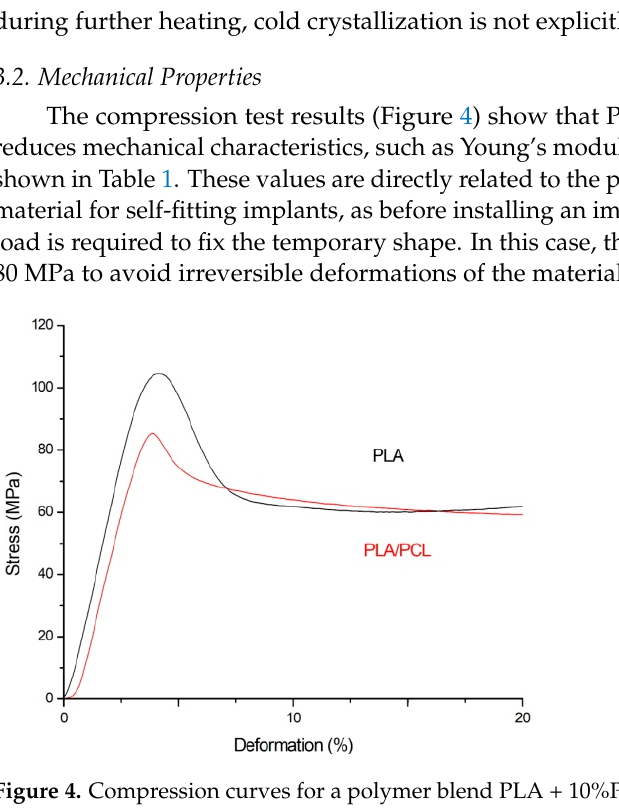
Figure 4. Compression curves for a polymer blend PLA + 10%PCL and PLA.